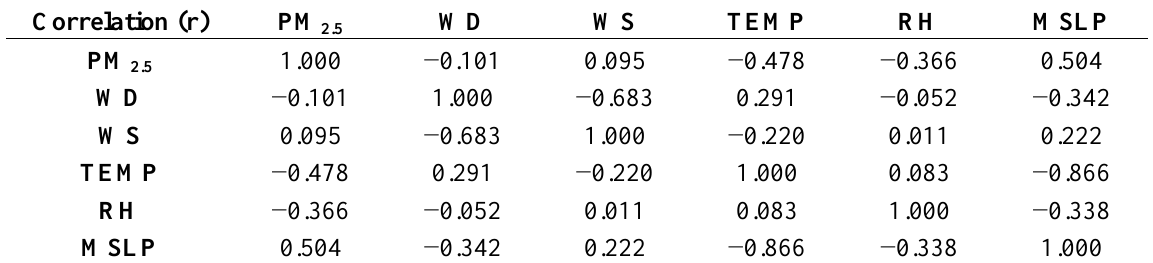
and meteorological factors for 2007 and 2008. 2.5